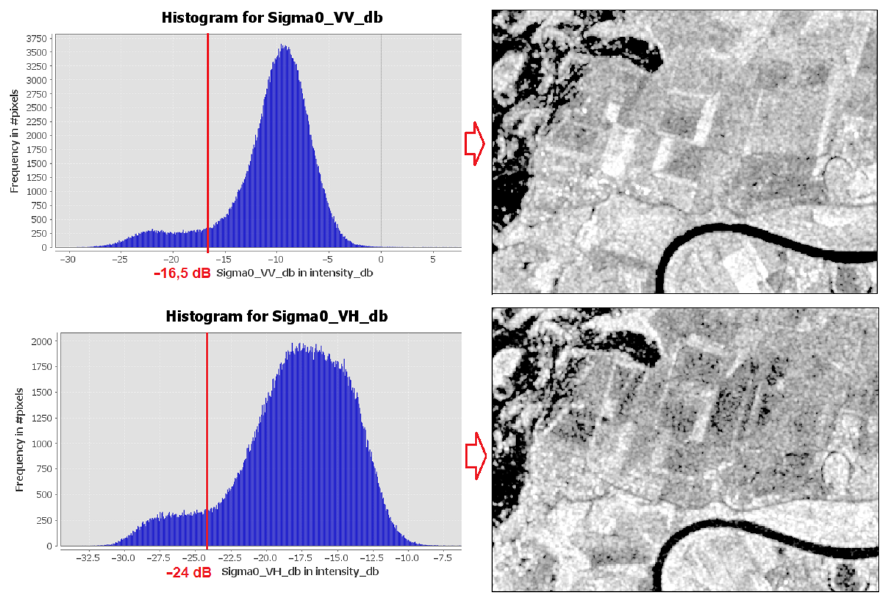
Figure 7. Comparison of Sigma 0 intensity in dB for both VV and VH polarisation in pixels using histograms in interval 02/2018.